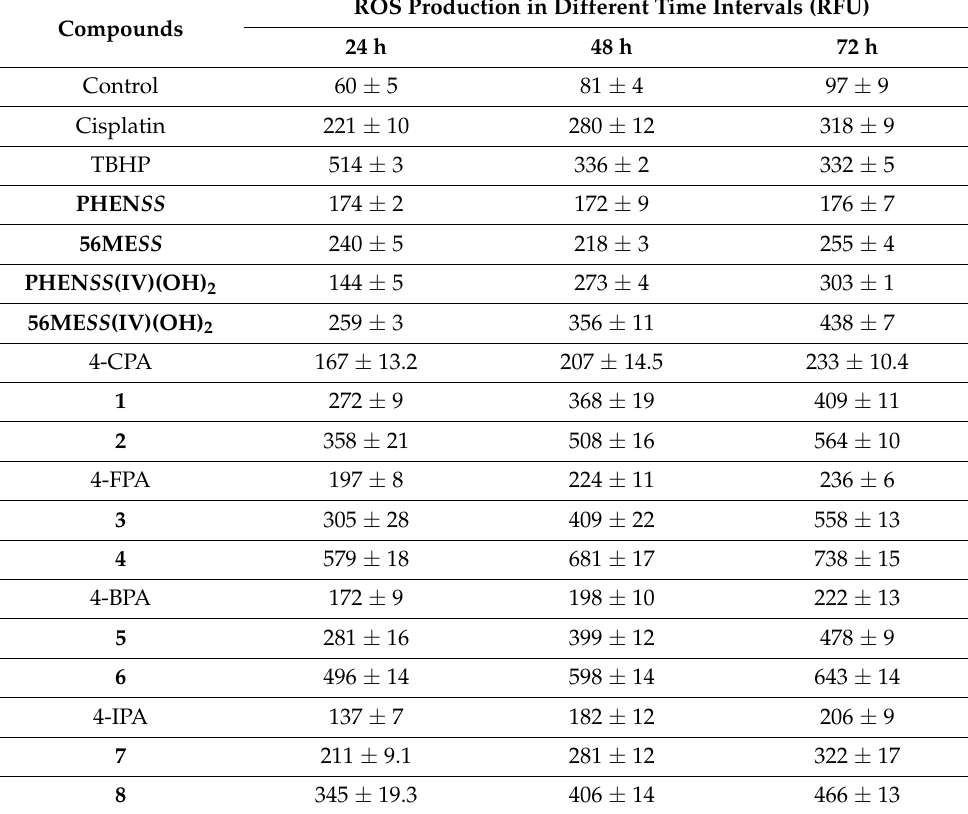
Table 8. ROS production upon treatment with 1 – 8 in HT29 colon cells at 24, 48, and 72 h. The data presented for platinum(II) ( PHEN SS and 56ME SS ), platinum(IV) ( PHEN SS (IV)(OH) 2 , and 56ME SS (IV)(OH) 2 ) precursors were obtained from a previous study [21].